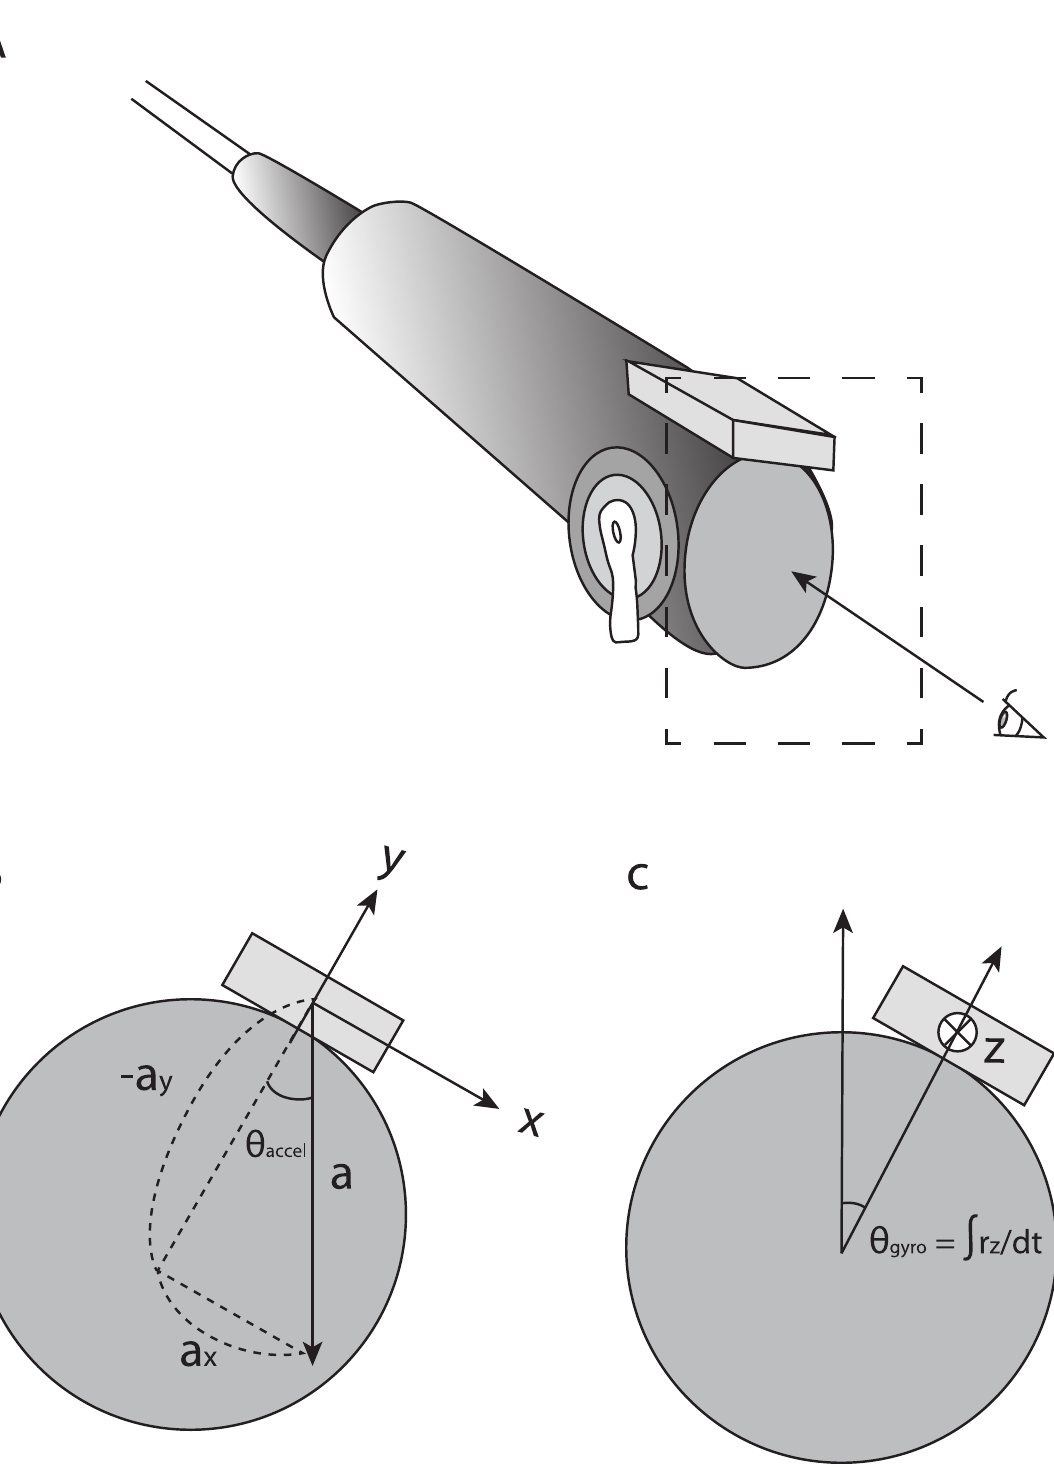
Fig 1. Axes definitions. A. the sensor attachment and the viewpointof the observerB. axes for the accelerometer. a x,y is the acceleration measuredby the accelerometer and θ accel is the rotationalangle calculatedfrom the accelerometer data. C. axes for the gyrosensor. r z is the angular velocity measured by the gyrosensorand θ gyro is the rotational angle calculatedfrom the gyrosensordata.